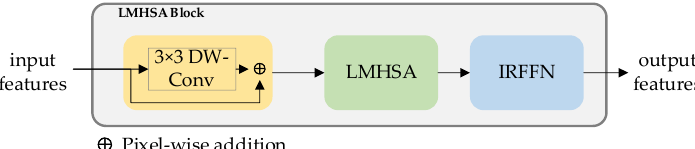
Figure 4. LMHSA block for RGB and Depth features extraction.